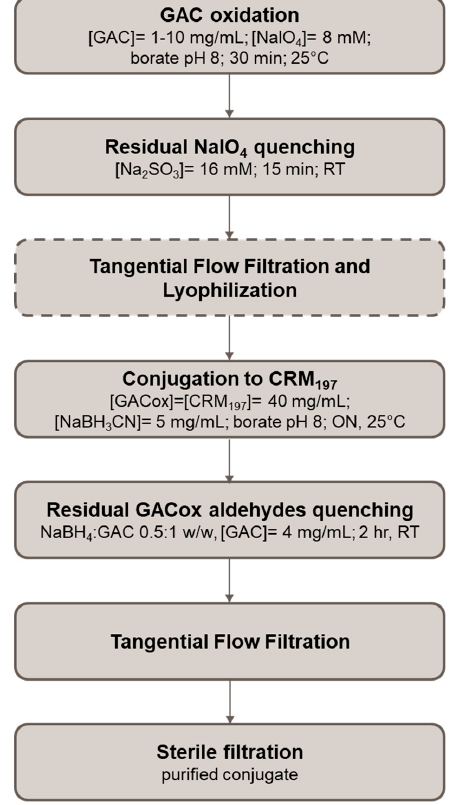
Figure 9. Flow chart of GAC to CRM 197 optimized conjugation process.